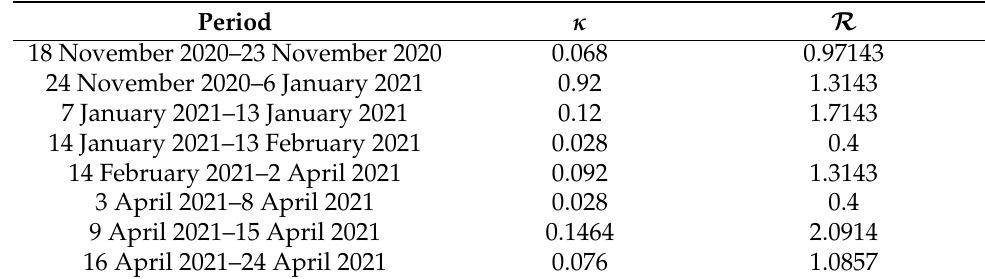
Table 2. Simulated period-depending average number of contacts per persone per time, κ , and actual reproduction number, R , for